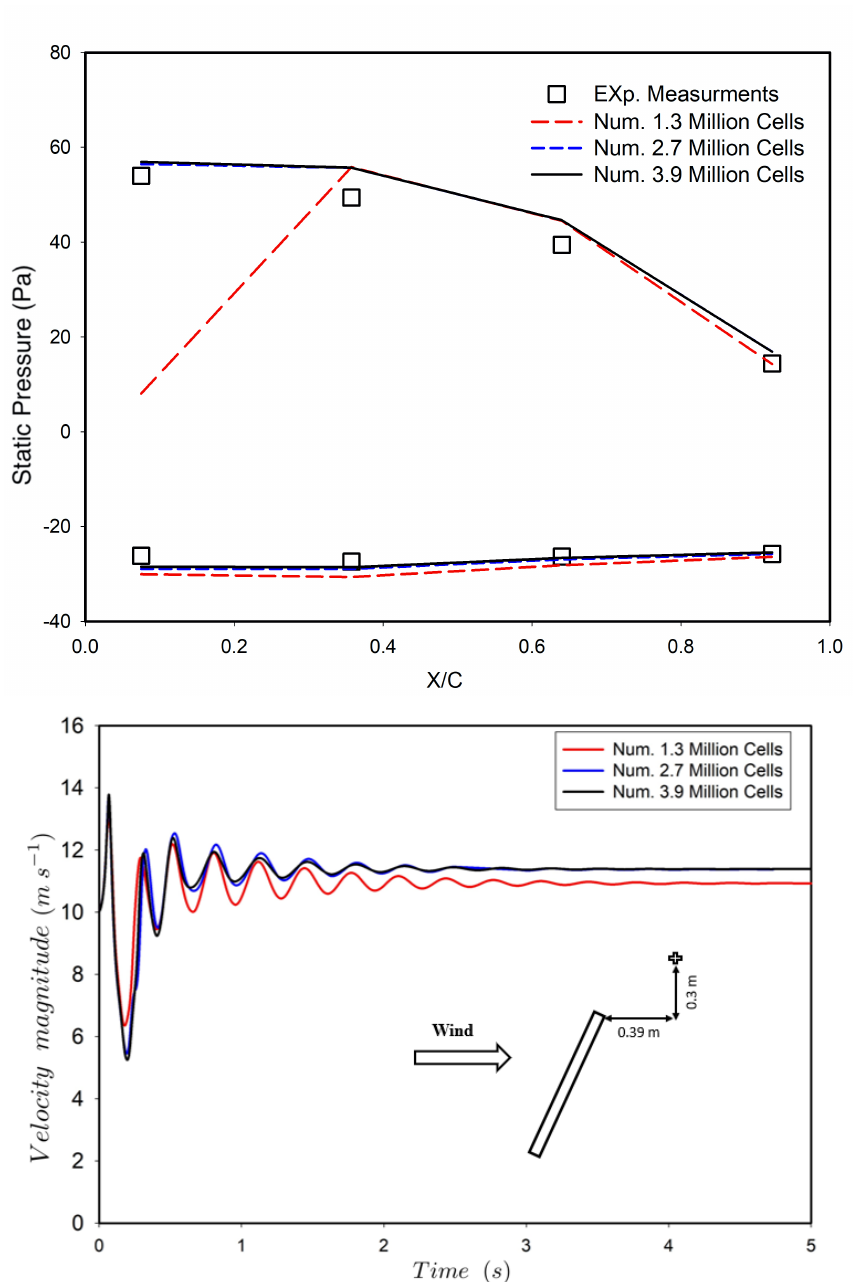
Figure 9. Effect of the grid on static pressure over the midline on the front and rear surfaces of the